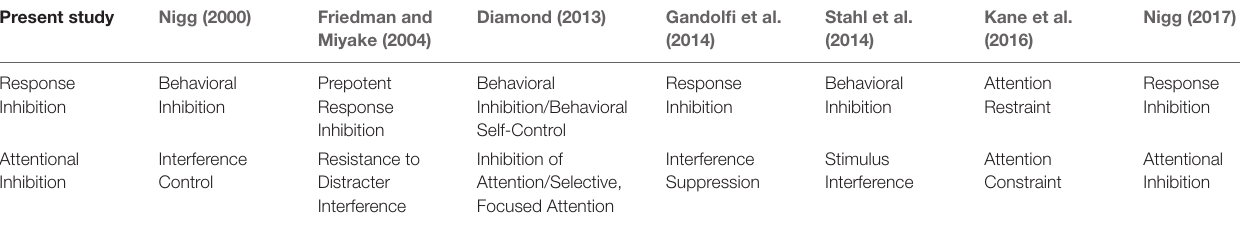
TABLE 1 | Comparison of terms used across studies to describe the two inhibitory control constructs of interest. Present